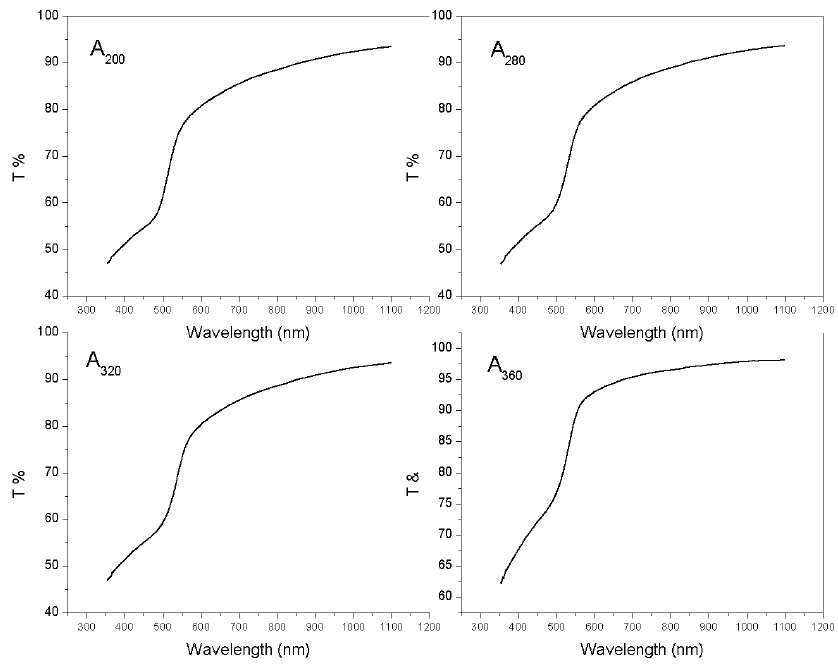
Figure 4. Transmittance spectra for different annealing temperatures for concentration A.